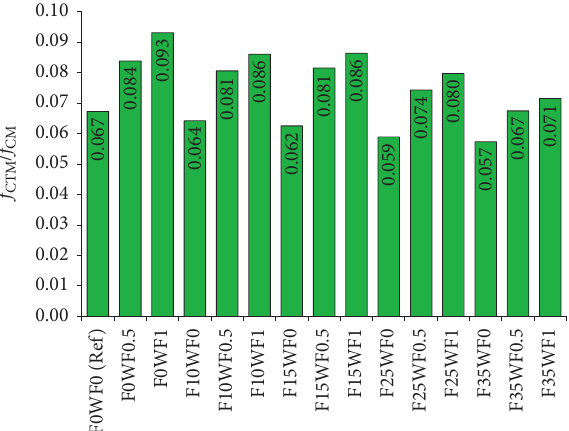
Figure 14: The f CRM of each HSC mix with different incorporation levels of FA and